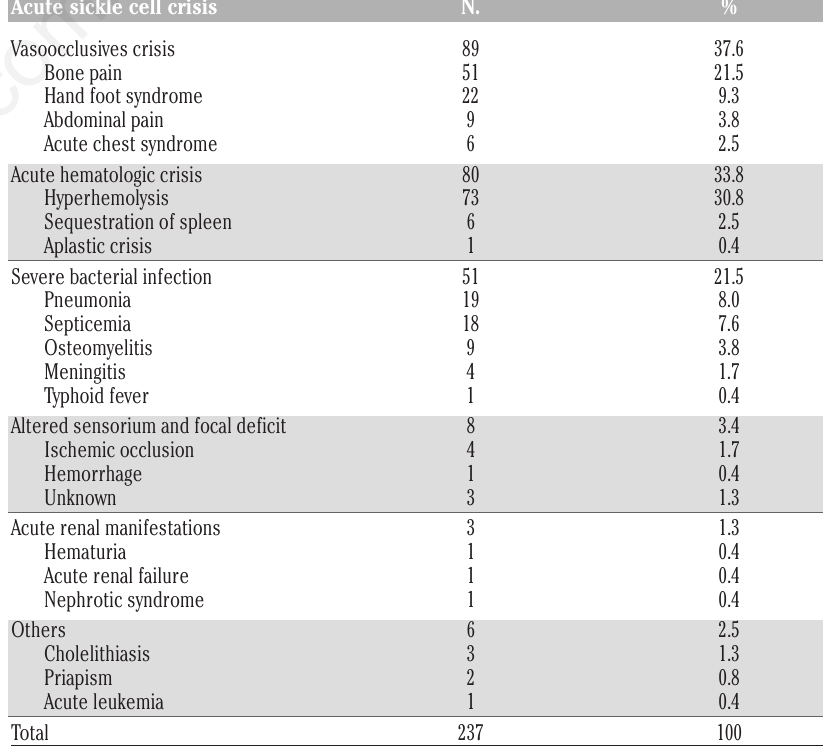
Table 3. Spectrum of 237 sickle cell acute events in the 108 study